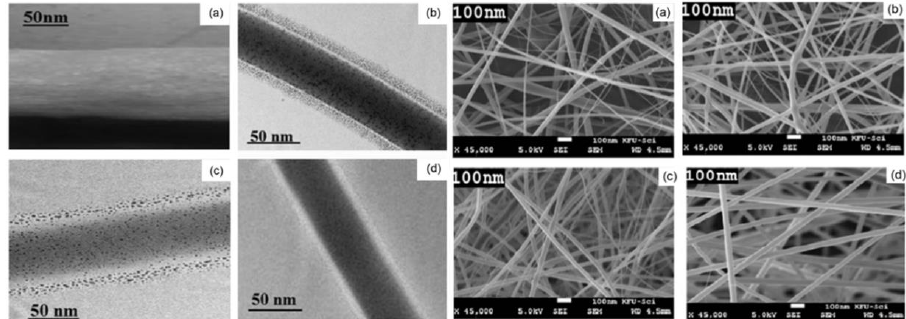
Figure 6. On the ( left ): TEM images of CMC electrospun nanofiber ( a ) and CMC-MNPs electrospun nanofibers CuNPs ( b ), FeNPs ( c ) and ZnNPs ( d ). On the ( right ): SEM images of CMC electrospun nanofiber ( a ) and CMC-MNPs electrospun nanofibers CuNPs ( b ), FeNPs ( c ) and ZnNPs ( d ). Reprinted by permission from [107], Springer Nature, Copyright 2017.